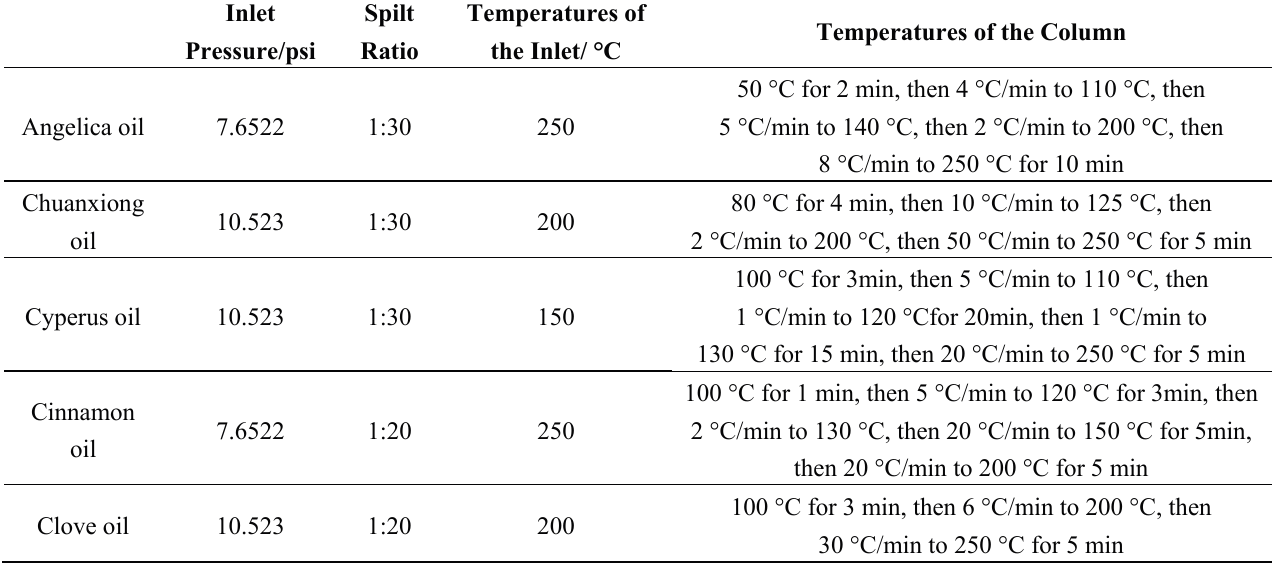
Table 7. Parameters of GC-MS